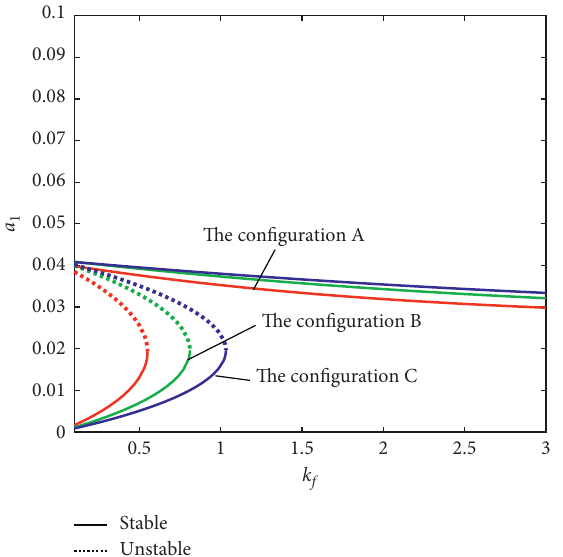
Figure 27: Amplitude versus cutting force coefficient with different ply sequences ( c � 0.01, σ � 2, L/d � 10, case I).